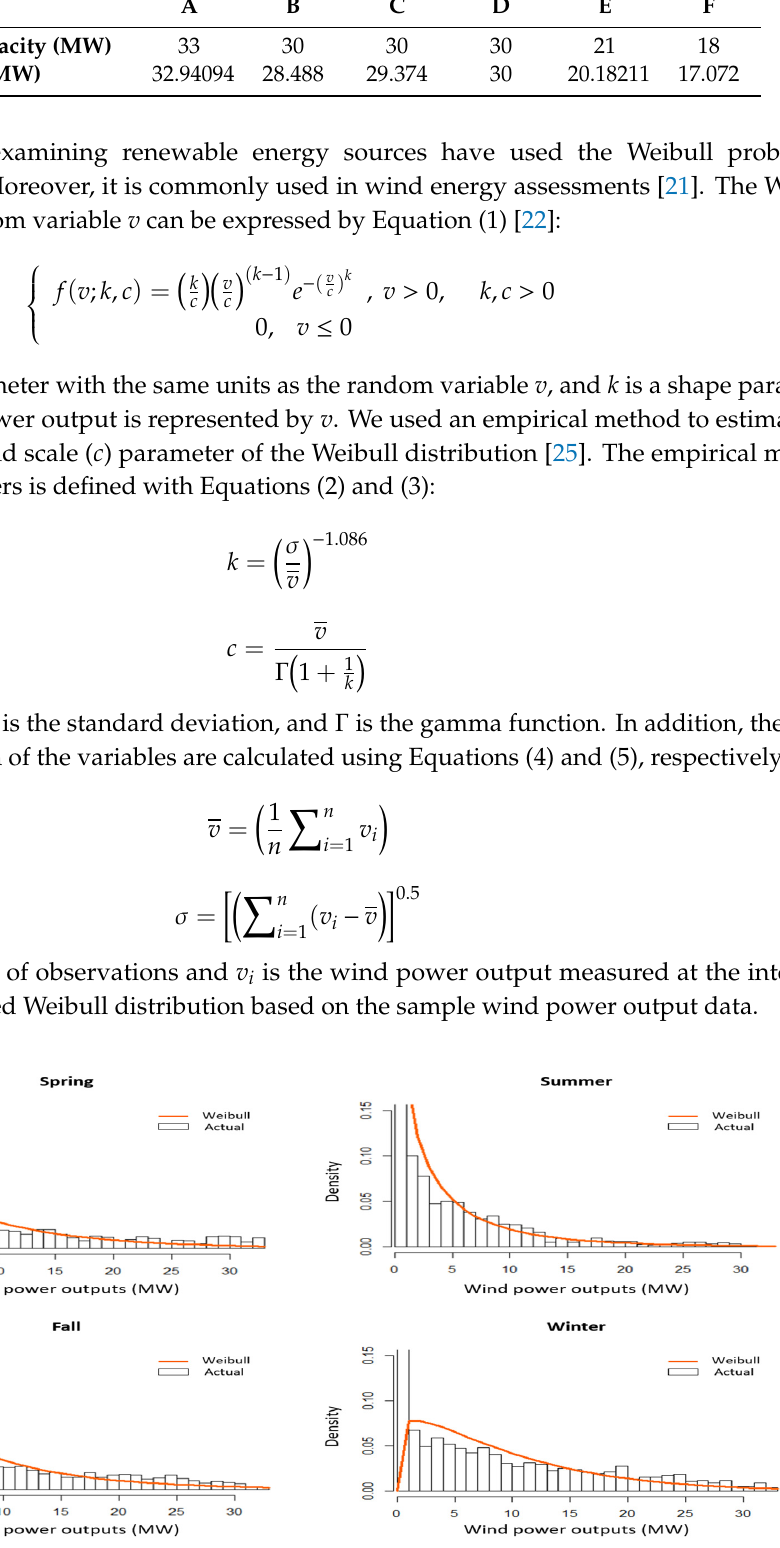
Table 3. Data from wind farms in Jeju Island.